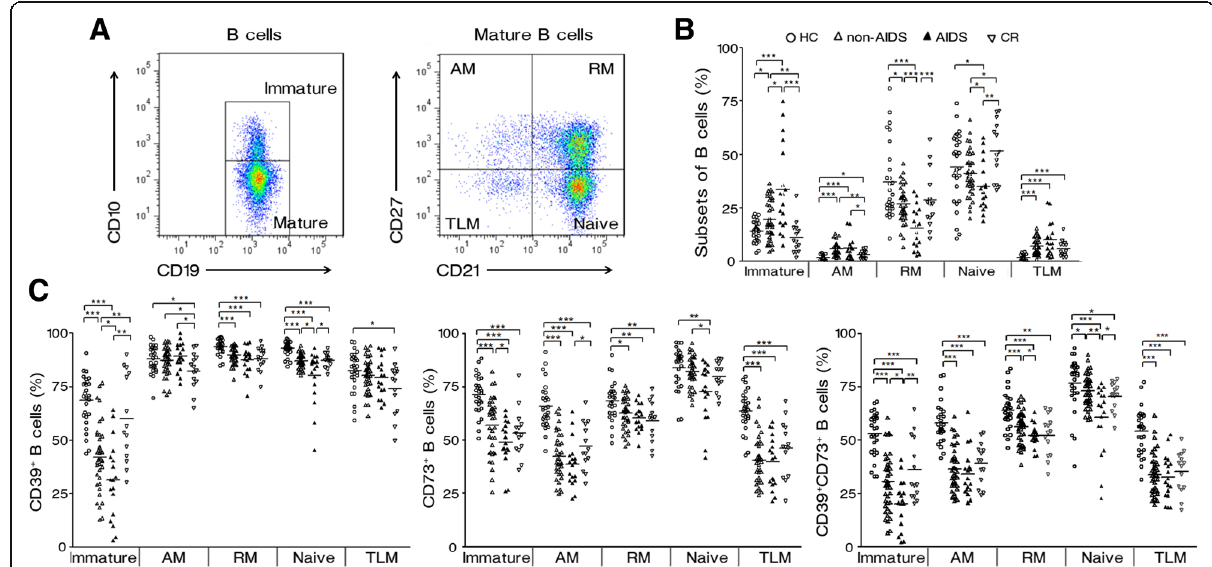
Fig. 2 CD39 and CD73 expression on B cell subsets in patients with chronic HIV-1 infection. a The gating strategy and phenotype of B cell subsets from one HIV-1+ patient. CD19 + B cells were firstly divided into immature CD10 + B cells and mature CD10 − B cells. Based on the differentiation markers CD21 and CD27, the mature CD10 − B cells were further divided into four subsets: CD21 − CD27 + AM B cells, CD21 + CD27 + Pooled data show the percentages of CD39 + , CD73 + , and CD39 + CD73 + B cells in each subset. * p < 0.05, ** p < 0.01, *** p < 0.001